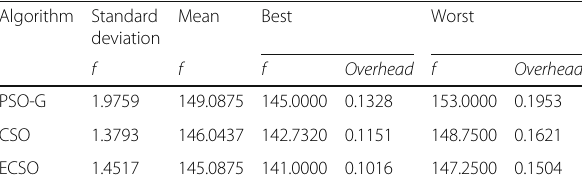
Table 7 Comparison of the optimization solutions with three